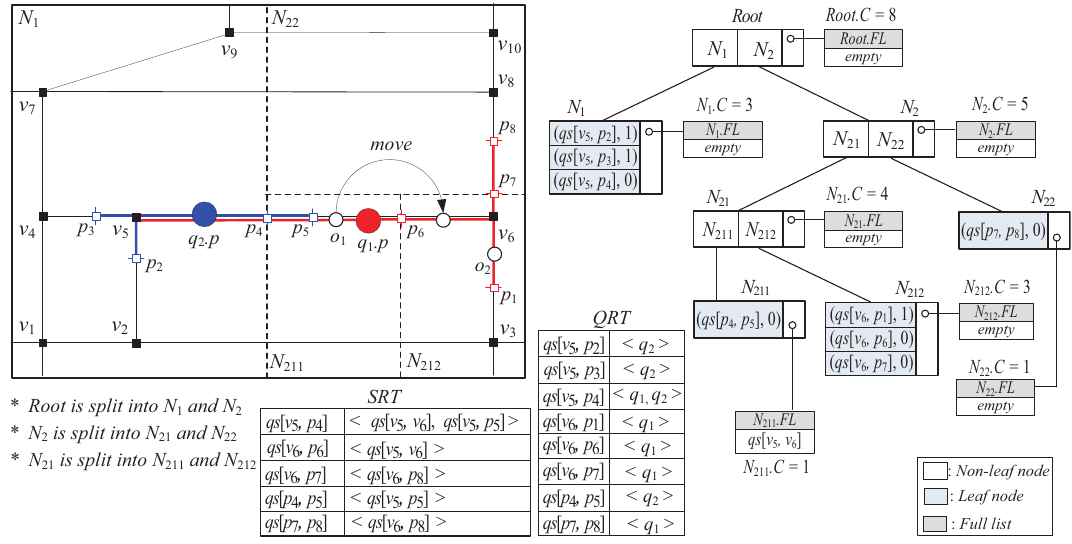
Figure 6. An example of the